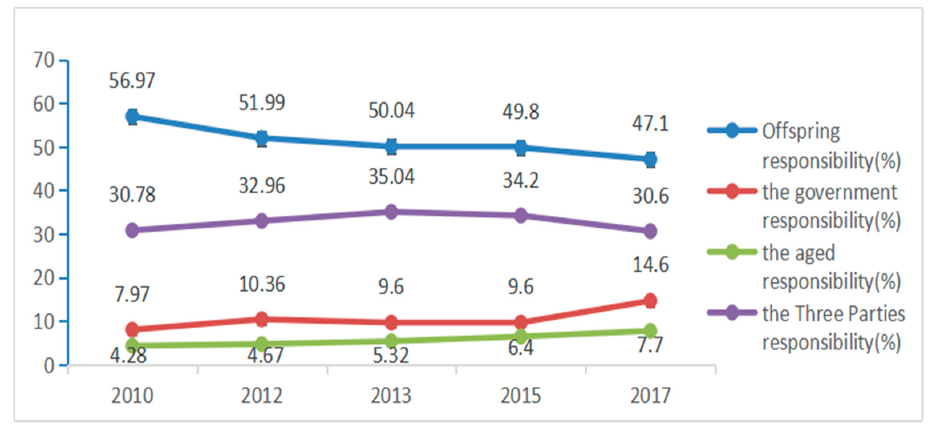
Figure 2. Changes in COACR in China during 2010–2017. Data source: [37] and the authors’ statis- tics.